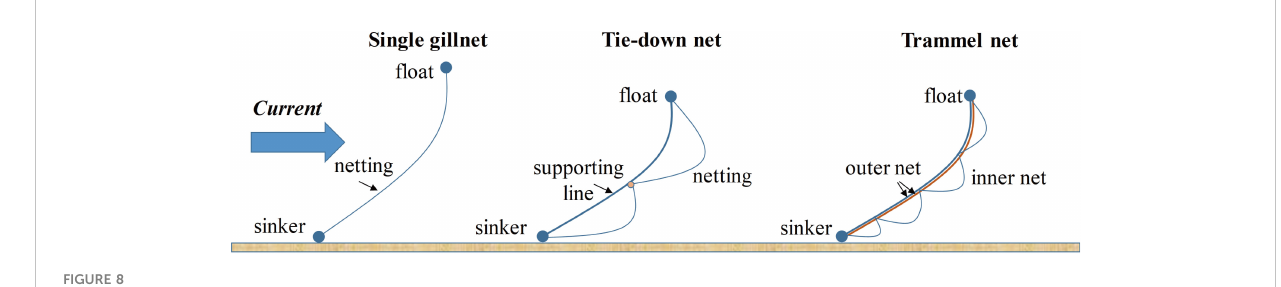
FIGURE 8 Diagram of expected underwater shape of each